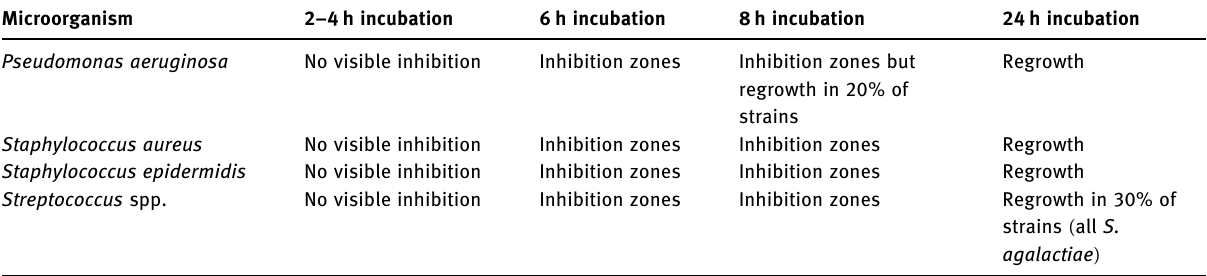
Table 1: Growth changes in the bacterial cultures after treatment with the liposomal ozonated oil